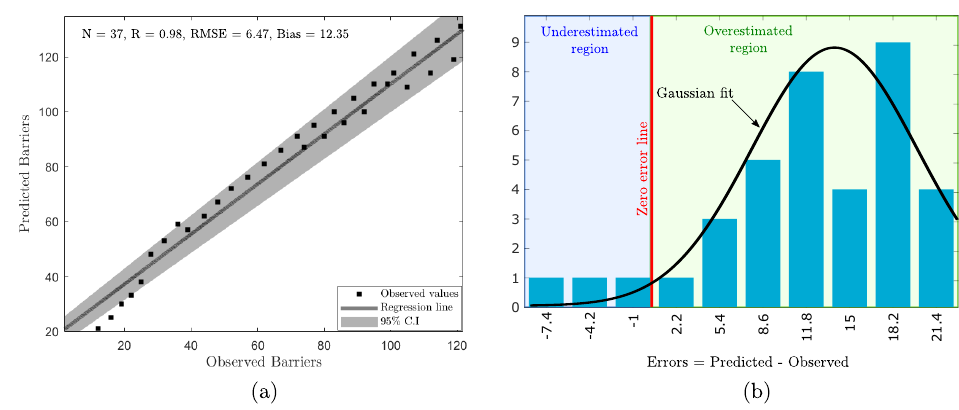
Figure 6. ( a ) Linear regression curve between the predicted result of LT-ZM-SVR model and observed values. ( b ) Error distribution analysis through error histogram.